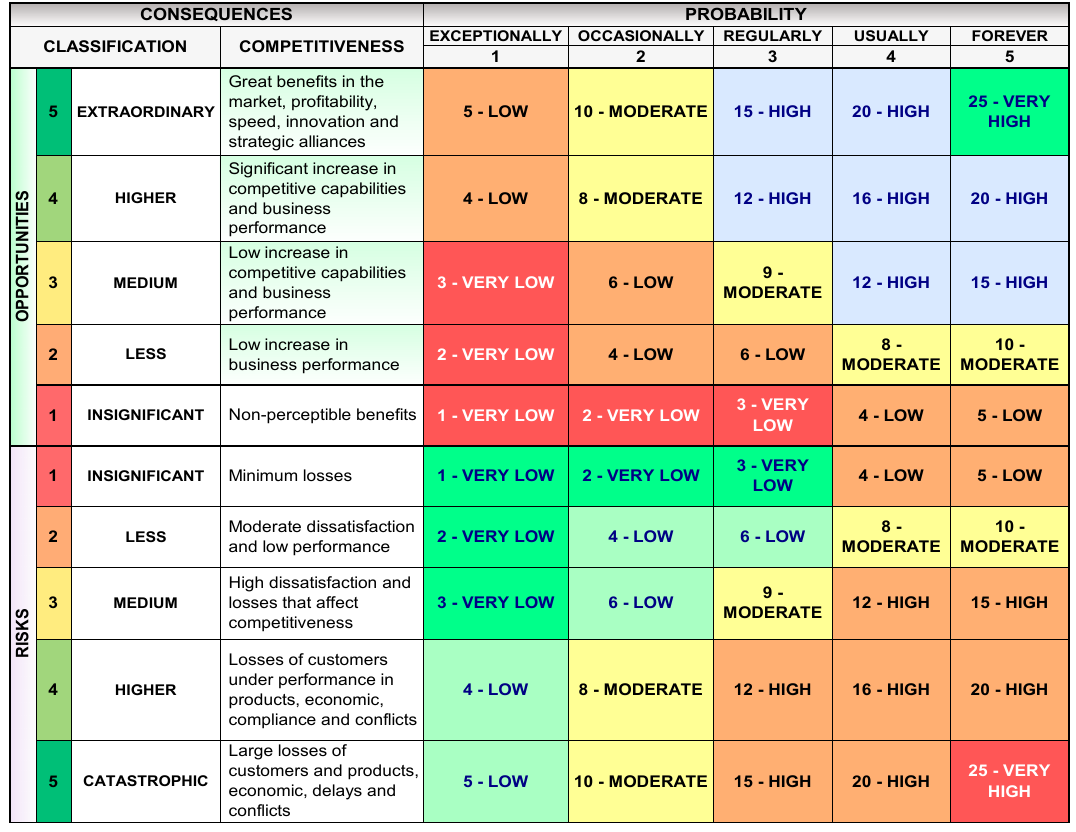
Figure 10. Parameterization of the application of the comprehensive R/O management model.